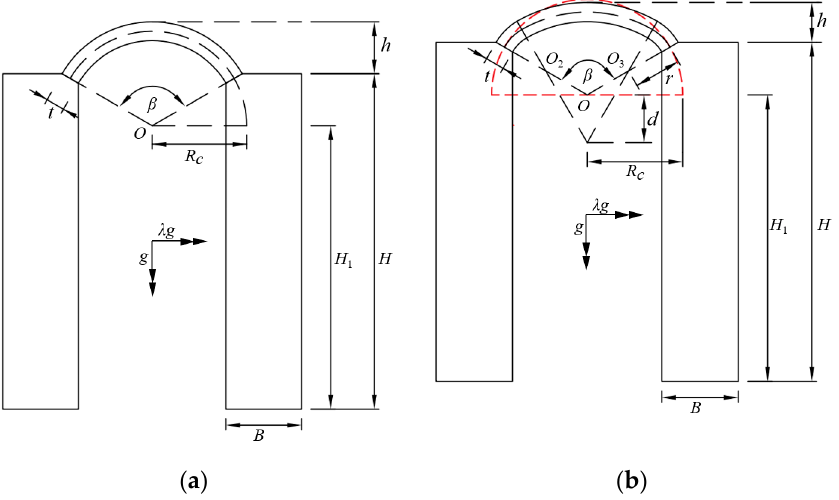
Figure 8. Geometry of buttressed arches (after [17]): ( a ) circular arch; ( b ) basket-handle arch. Similar to that in Section 3.1, each arch is composed of 11 voussoirs. Geometric parameters of the investigated buttressed arches are: (i) circular buttressed arch, R c = 1.0 m, H 1 / R c = 3, B / R c = 0.8 and